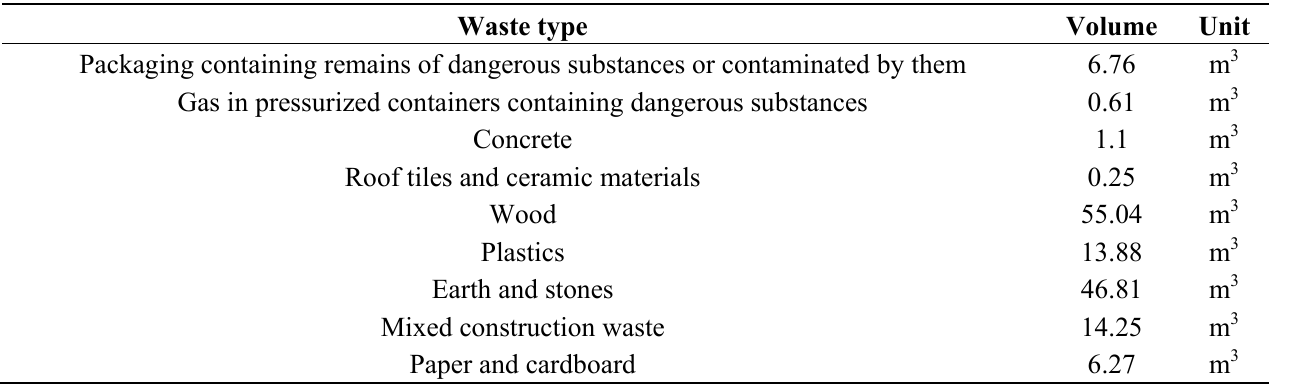
Table 4. Amounts of construction site waste produced in the building.